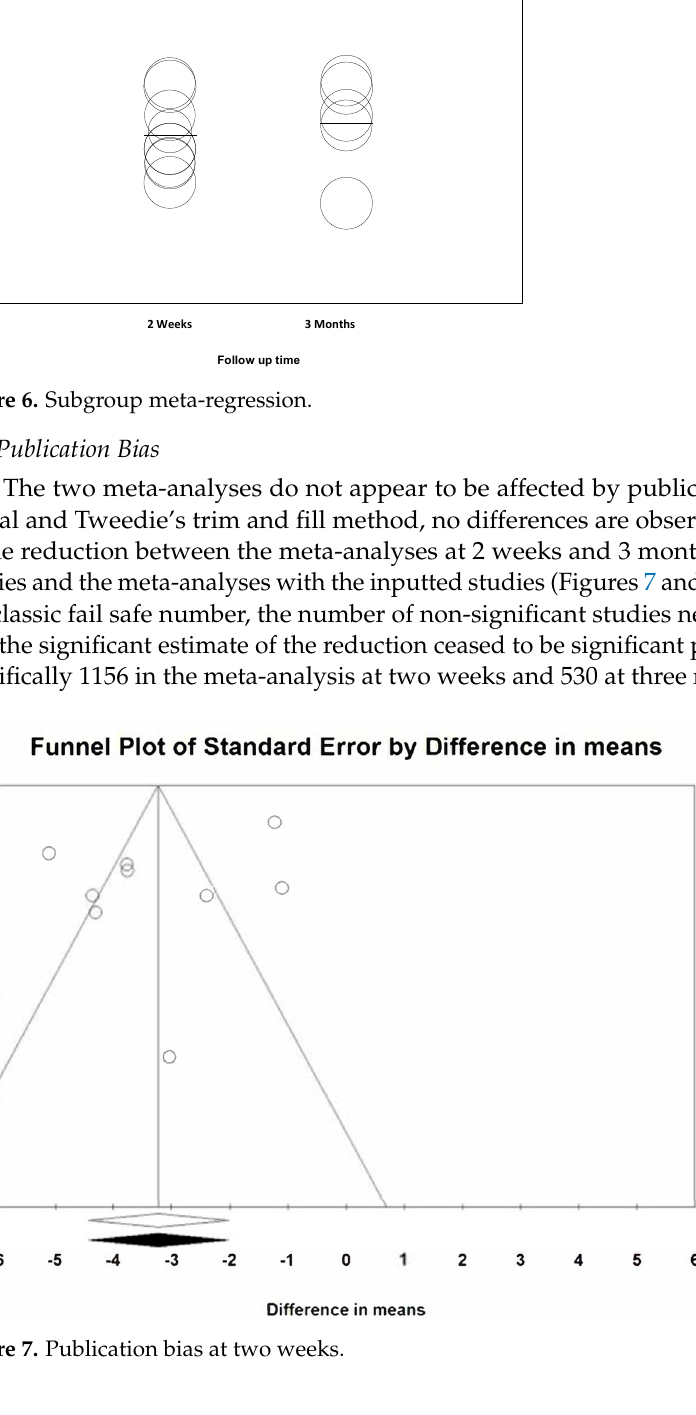
Figure 5. Meta-regression analysis units of BTX-(cid:31) /gummy smile reduction at 3 months.